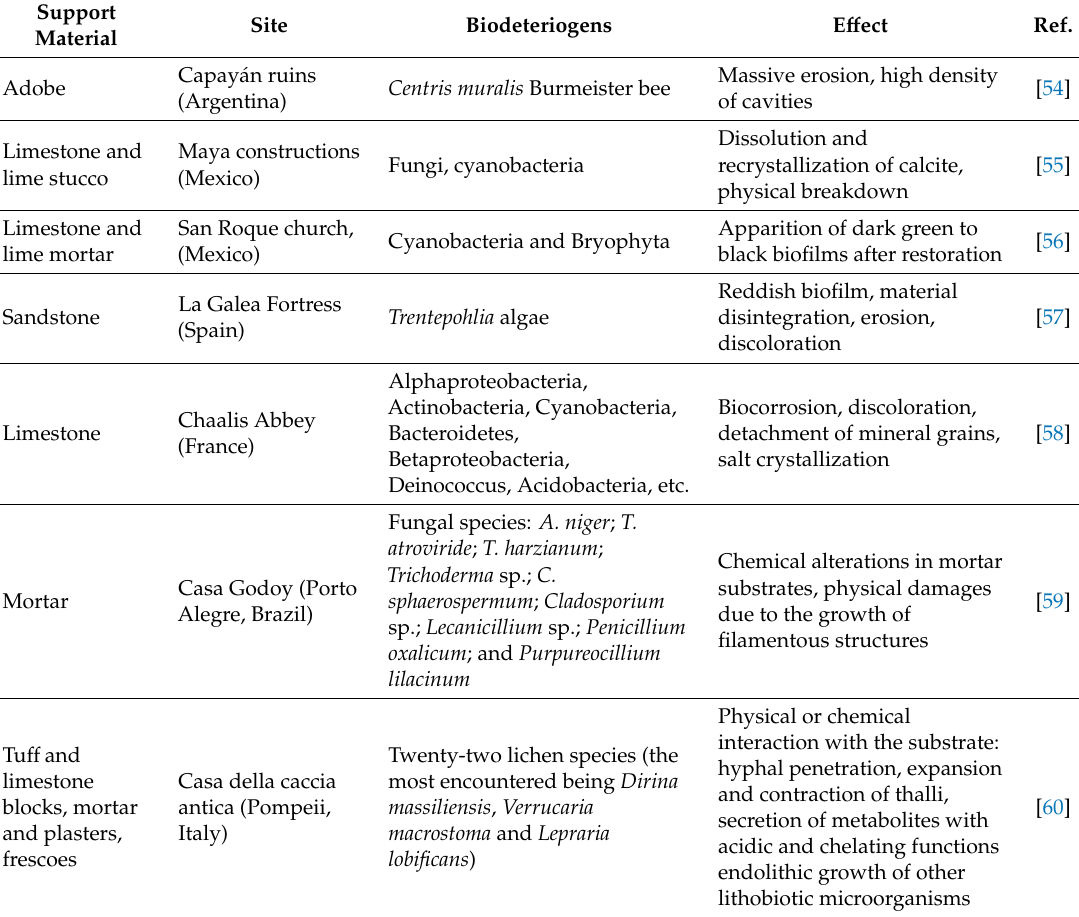
Table 3. Biodeterioration of masonry materials (selected